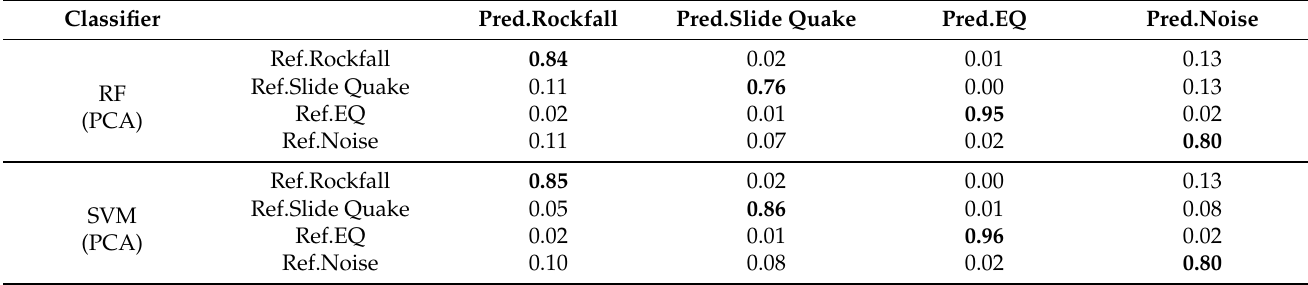
Table 4. Mean Confusion Matrix (sensitivity score) for 50 runs (feature construction only) a